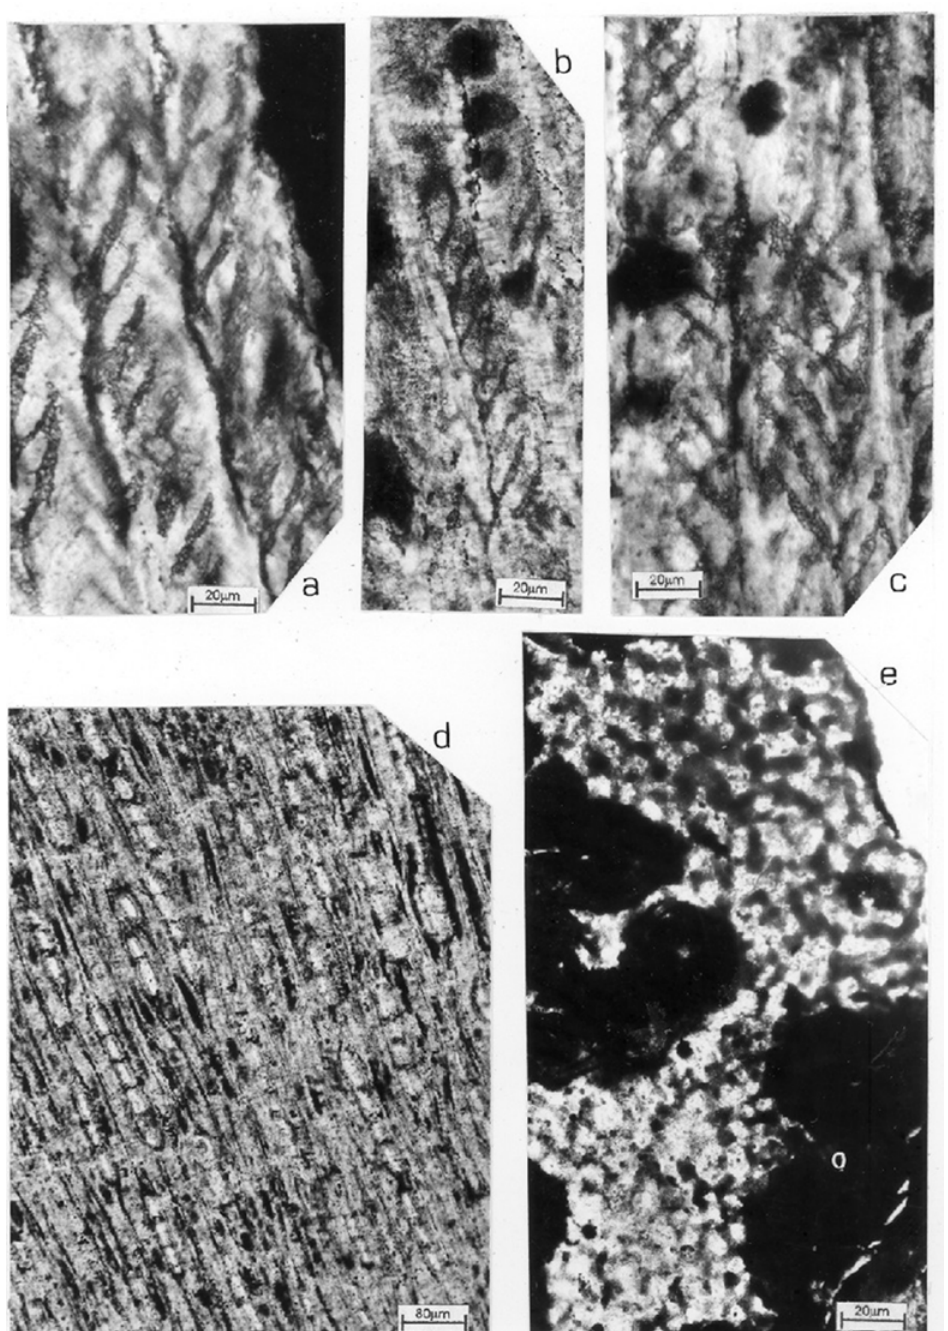
Fig. 3 – Sommerxylon spiralosus n.gen. et n.sp. Radial section – a, b: detail of simple spiral thickenings in the walls of the tracheids. c: spiral thickenings superposed. Tangential section – d: medullary rays. Transverse section – e: nest of parenchymatous cells in the pith associated to the irregularly